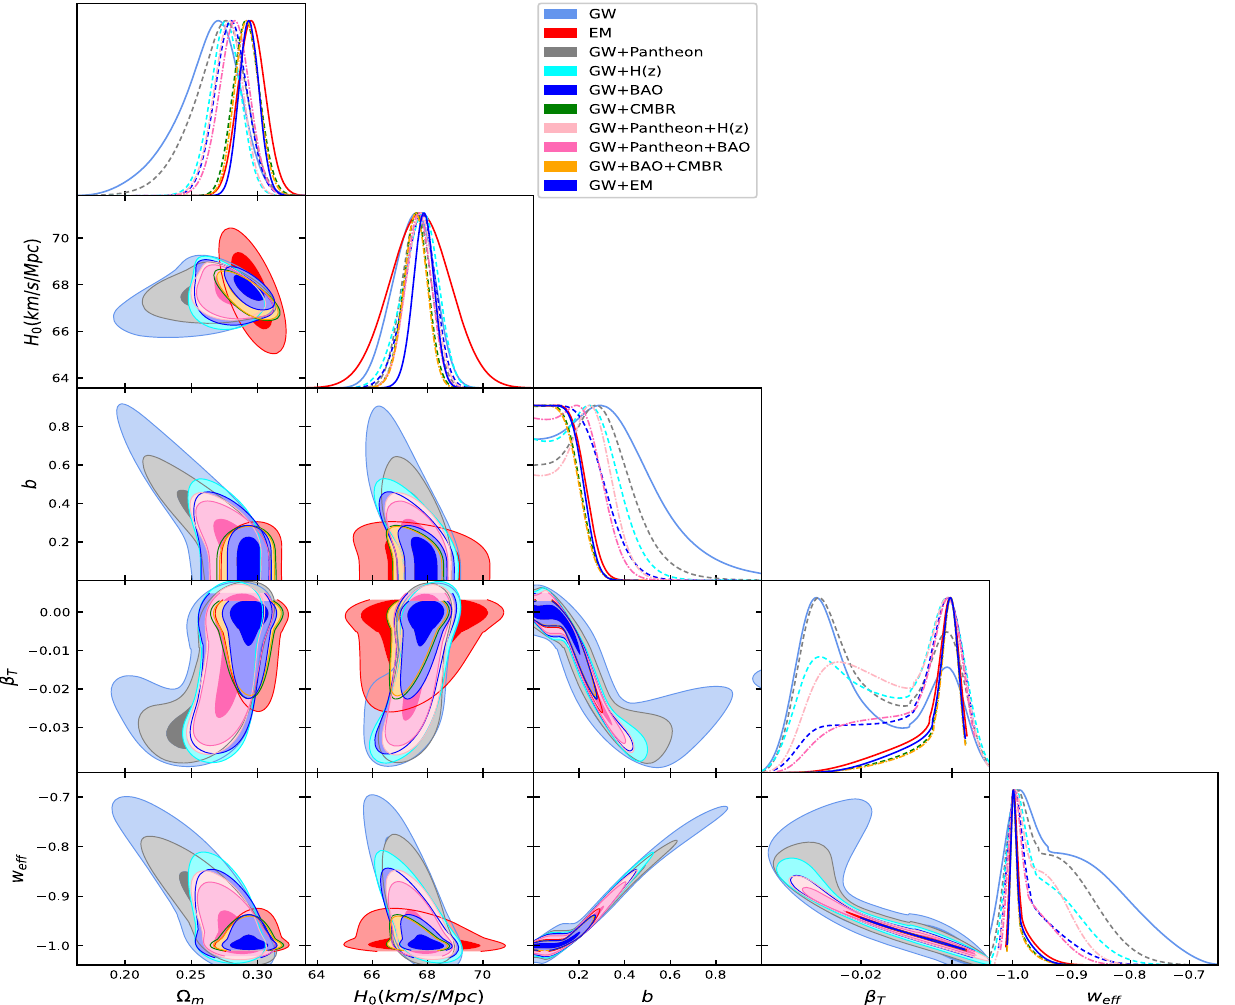
Fig. 3 The probability density functions (pdfs) , the 68% (1 σ ) and 95% (2 σ ) confidence regions for the parameters ( (cid:4) m 0 , H 0 , b , β T and w e f f ) in the f e CDM model